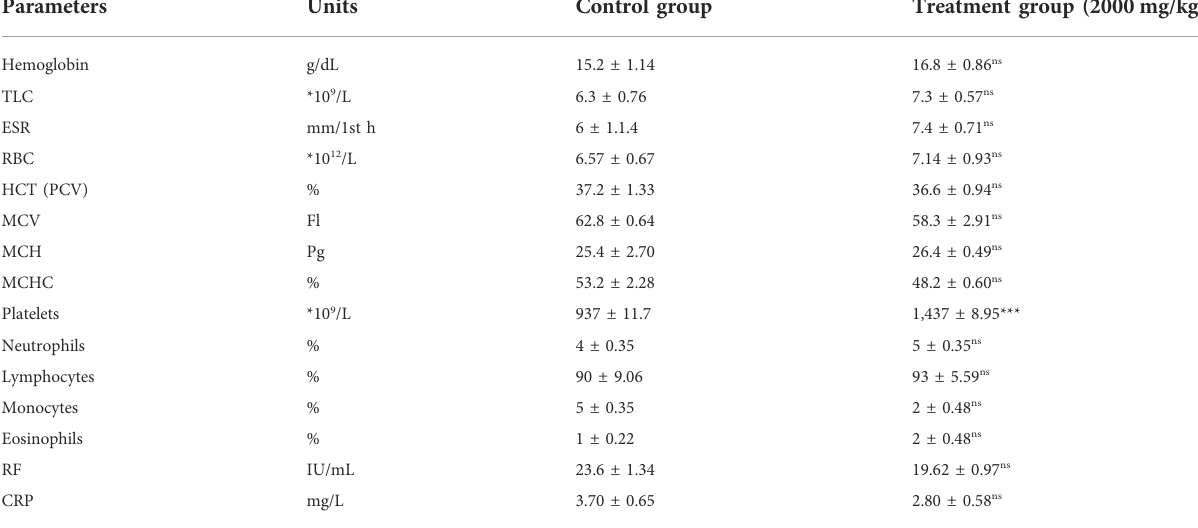
TABLE 4 Effect of ABEE (at limit dose 2000 mg/kg p.o.) on hematologic variables in acute toxicity study.